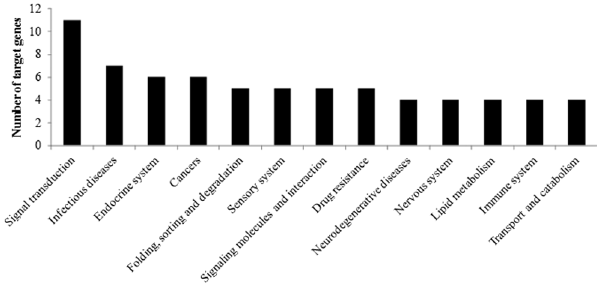
Figure 5. Distribution of target genes in KEGG